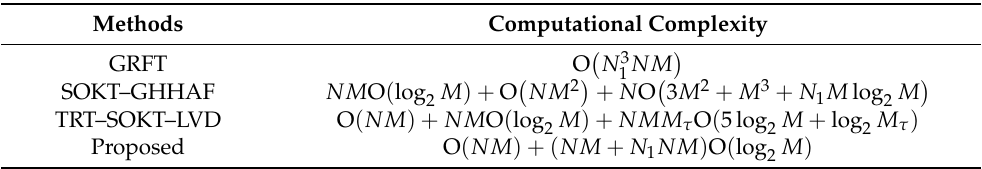
Table 2. Comparison of computational complexity. GRFT, generalized radon Fourier transform; SOKT–GHHAF, second-order KT and Hough-generalized high-order ambiguity function; TRT– SOKT–LVD, time reversing transform, second-order KT, and Lv distribution.